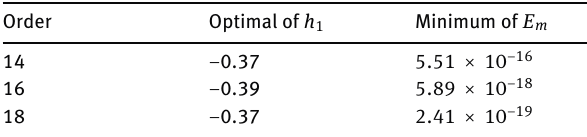
Table 2: Optimal value of h 1 at different order of approximations Order